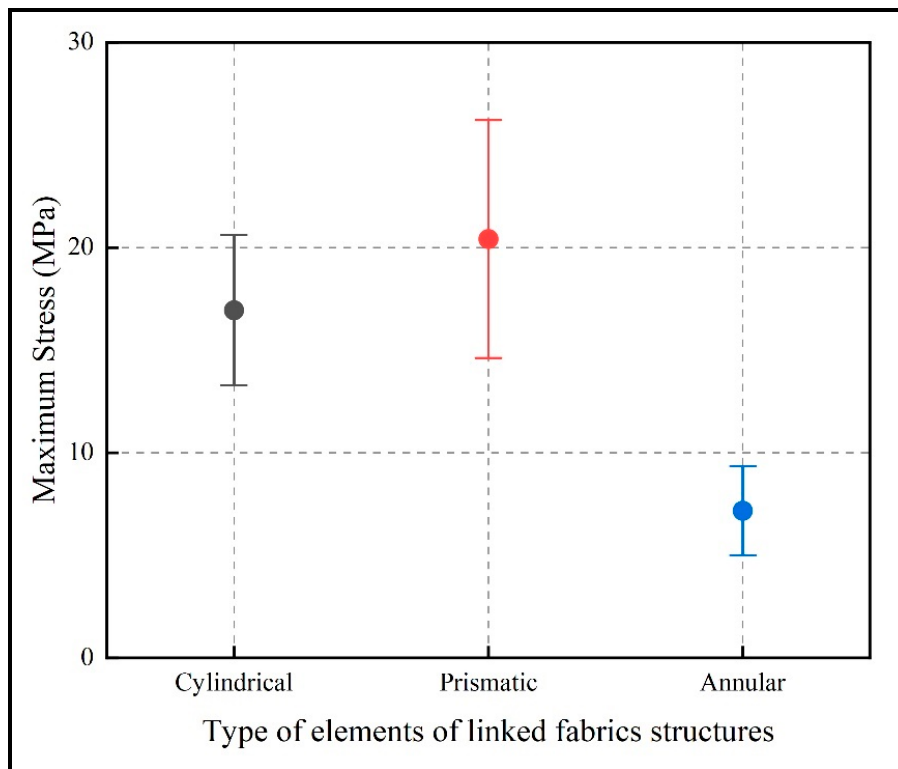
Figure 8 . Average stresses of the different structures. Figure 8. Average stresses of the different